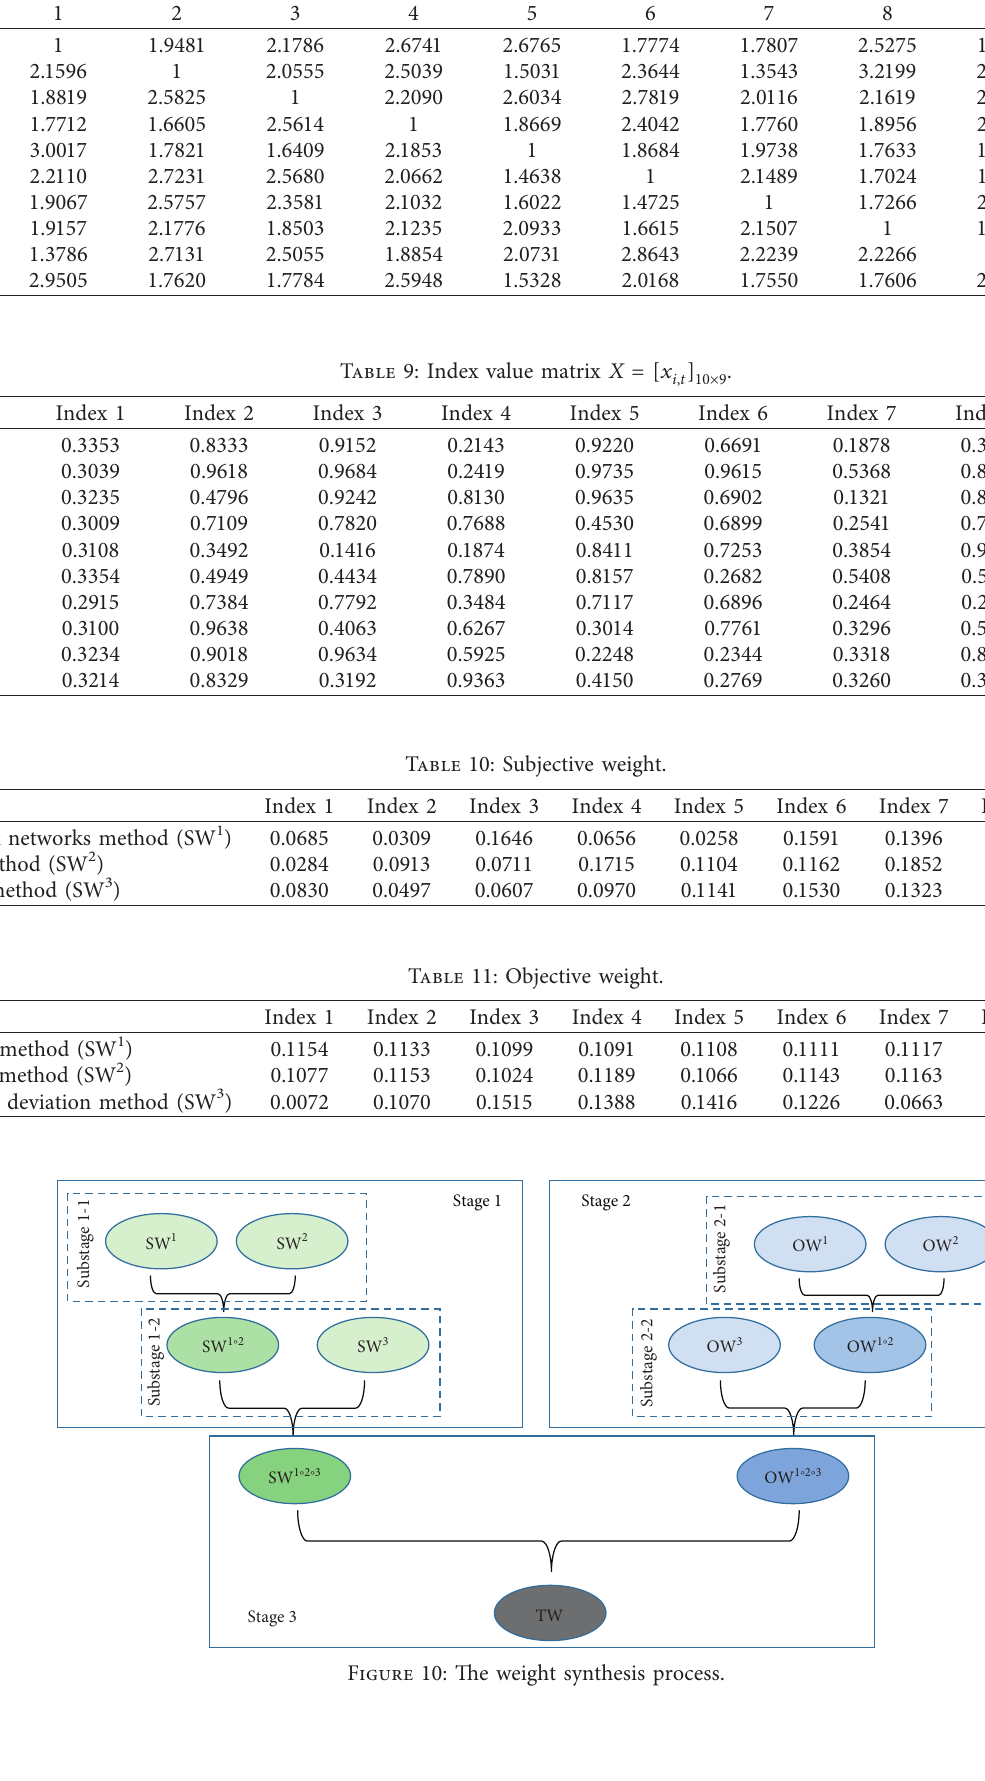
Table 8: Real number form matrix Λ 1